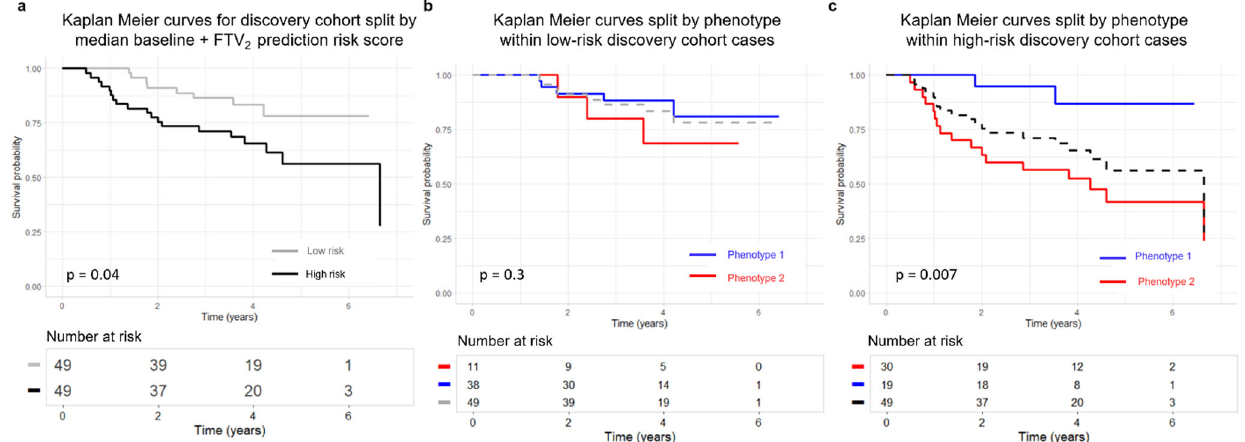
Fig. 4 Survival Analysis versus Risk Score. Survival versus risk score for the discovery cohort calculated by a Cox model using baseline model covariates (age, HR status, and HER2 status) and functional tumor volume at T2 (FTV 2 ). Split on above versus below median risk ( n = 100) ( a ). b Split on phenotype within the low-risk stratum ( n = 100). c Split on phenotype within the high-risk stratum (n = 100). Table 4 Univariable and multivariable Cox models of RFS within the discovery cohort. Model c-statistic 95% CI for c-statistic Model p a p -versus nested model MammaPrint 0.63